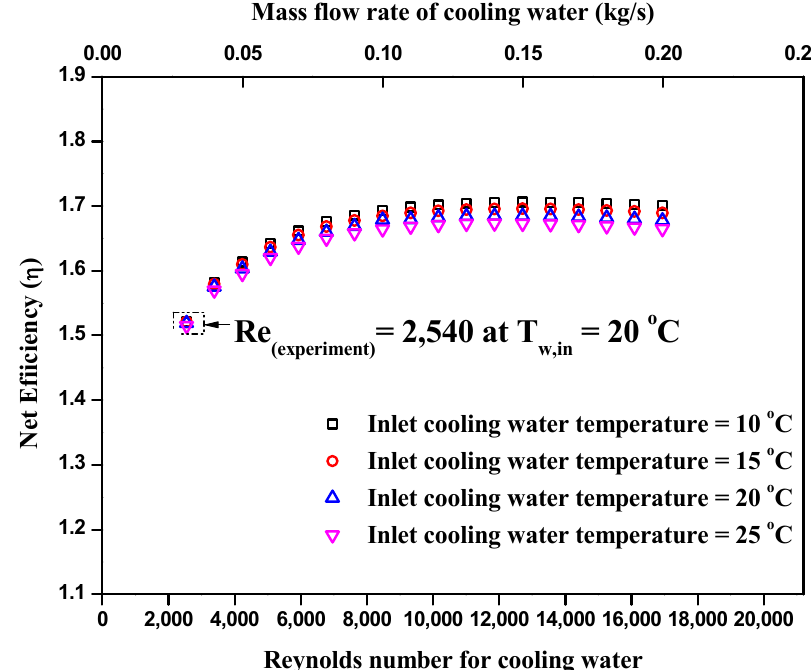
Figure 14. Variation in maximum net efficiency of TEG set ‐